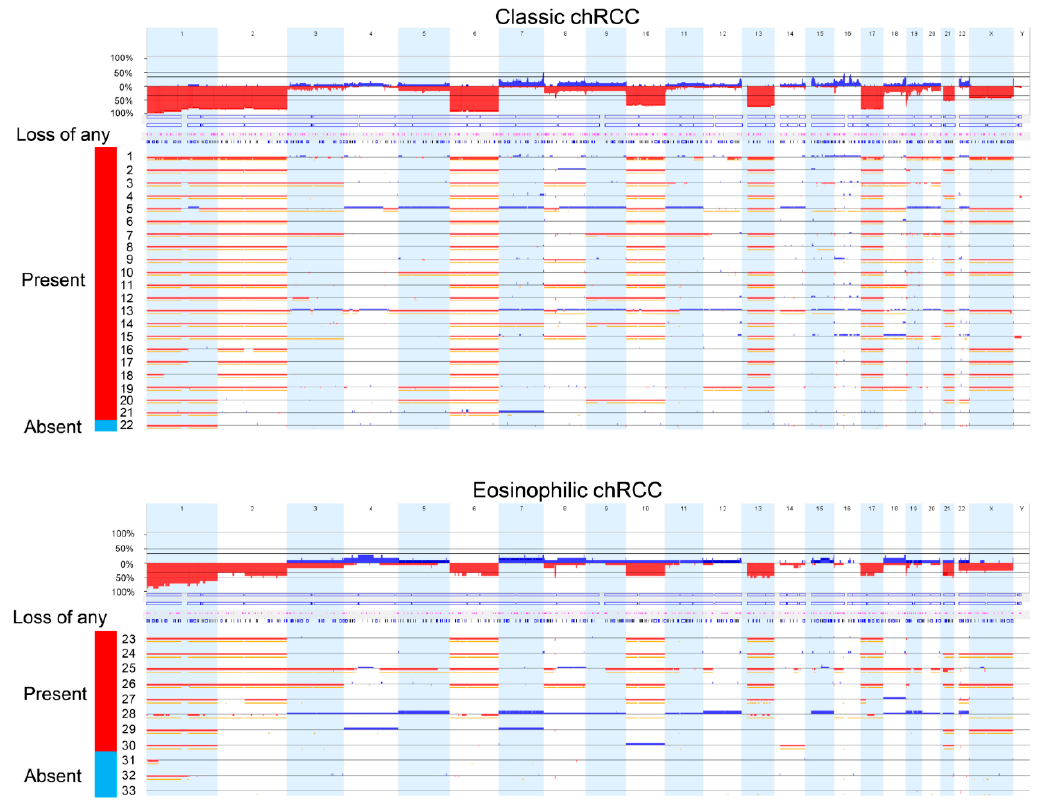
Figure 2. Copy number (CN) alterations and copy-neutral loss-of-heterozygosity detected by Affymetrix OncoScan® CNV Assay of 22 classic chromophobe renal cell carcinomas (chRCCs) (upper panel) and 11 eosinophilic chRCCs (lower panel) in the Swiss cohort. Red signal, blue signal, and yellow signal show copy-number loss, copy-number gain, and copy-neutral loss-of-heterozygosity, respectively. Loss of any: Loss of any chromosome among chromosome 2, 6, 10, 13, 17, or 21. Red: Present, Blue: Absent.